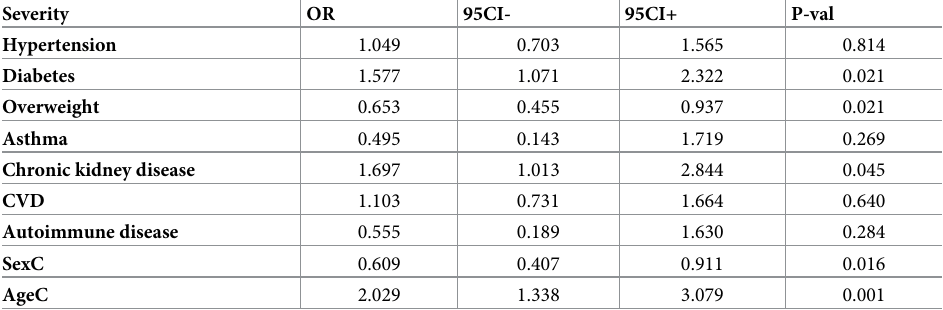
Table 5. Binomial logistic regression coefficients of discrete variables predicting fatality from joint conditions as exposures. Fatality